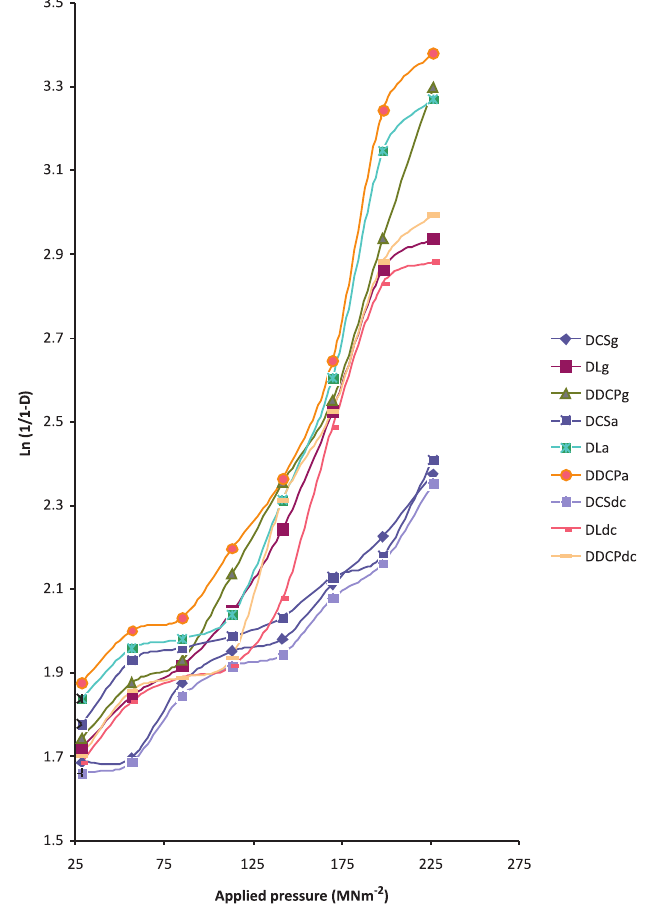
FIGURE 1 - Heckel plots for Diclofenac tablet